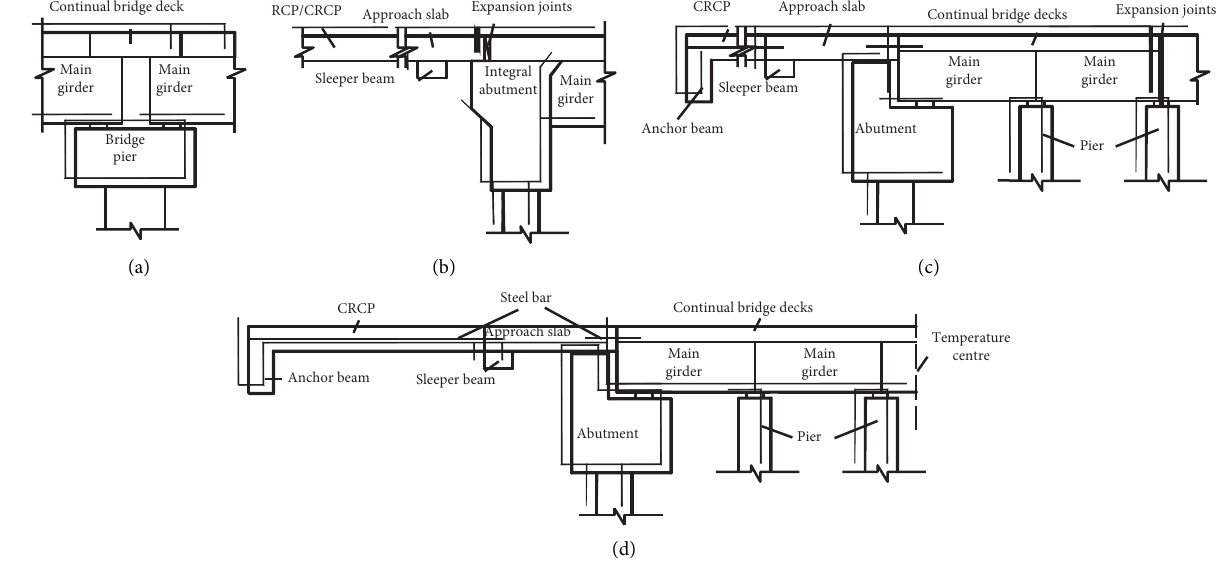
Figure 1: Structural types of jointless bridges: (a) JDBs, (b) IABs/SIABs, (c) SJSBs, and (d)